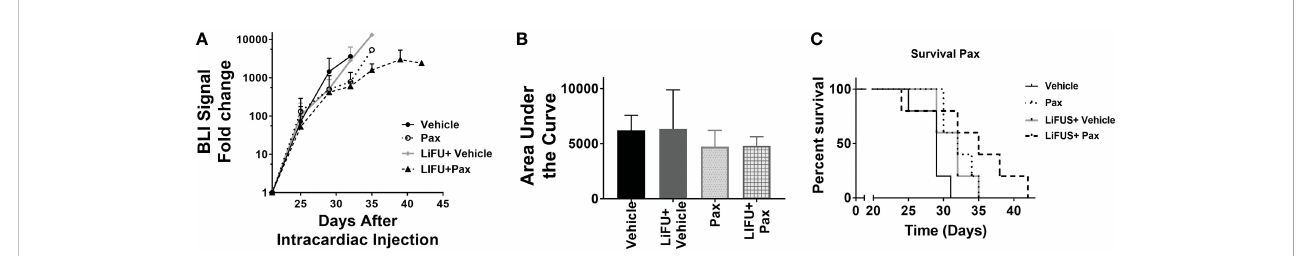
FIGURE 4 Concurrent therapy of LIFU with paclitaxel does not decrease tumor burden or increase survival in a preclinical model of brain metastasis of breast cancer. (A) BLI signal versus time in mice with treatment beginning on day 21 (n=5-7). Mice treated with 10mg/kg Pax (B) Area under curve (C) Kaplan- Meier survival plot of mice starting 21 days after intracardiac injection of MDA-MB-231Br breast cancer